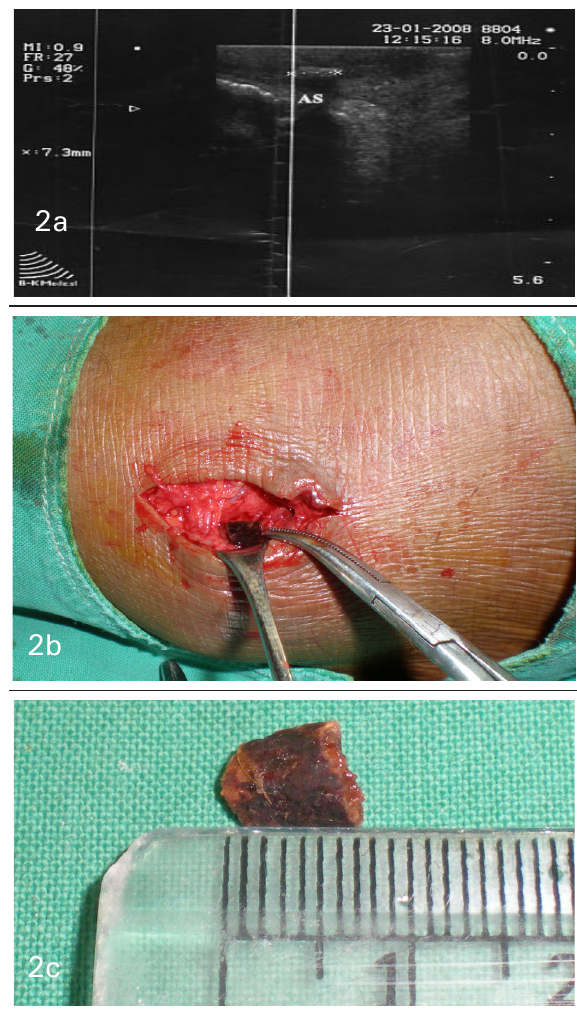
figure 2: 2b.Ultrasonography with linear shadow with distal acoustic shadow (As) 2b, 2c. Wooden piece (arrow) removed from